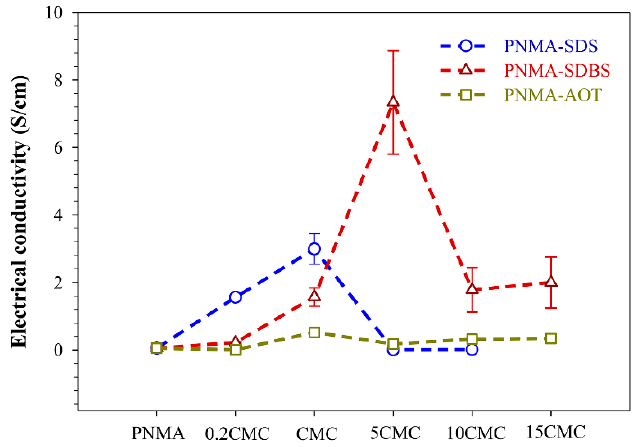
Figure 5. σ values of the PNMA synthesized with different anionic surfactants SDS, SDBS, AOT and at various concentrations: 0.2, 1, 5, 10, to 15 CMC. (Each average value was obtained from 3 samples × 3 repeated measurements).